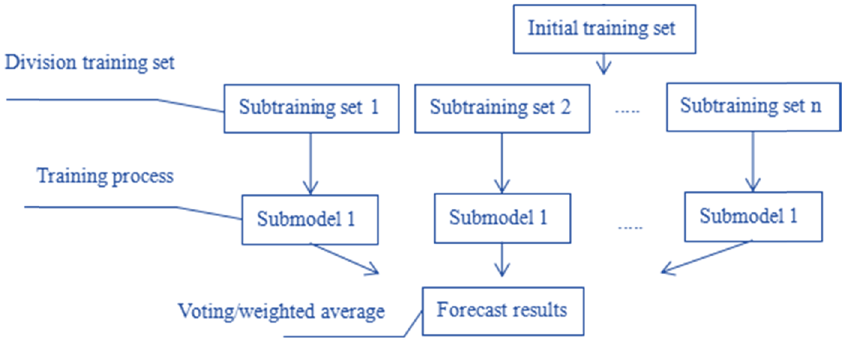
Figure 2: Balanced sample